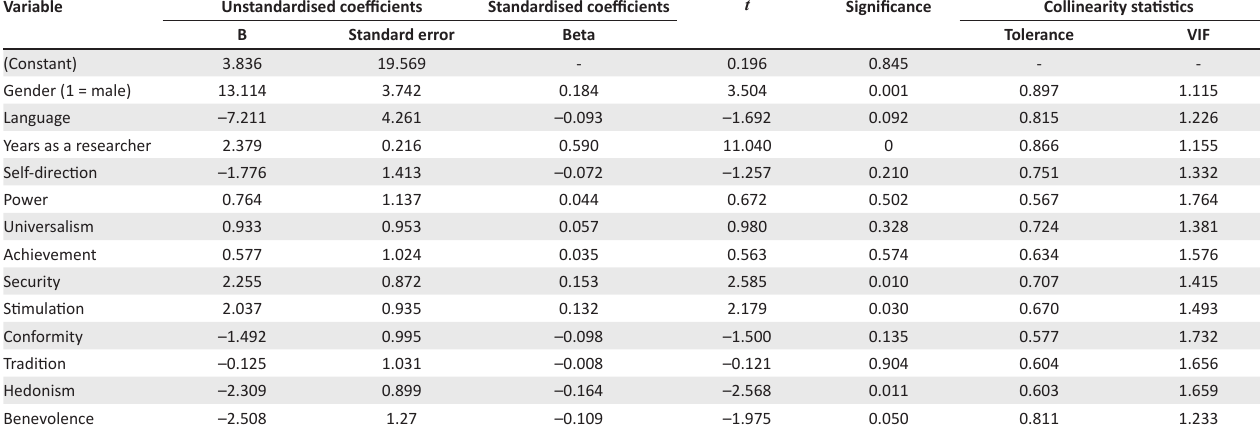
TABLE 4: Multiple linear regression analysis results.